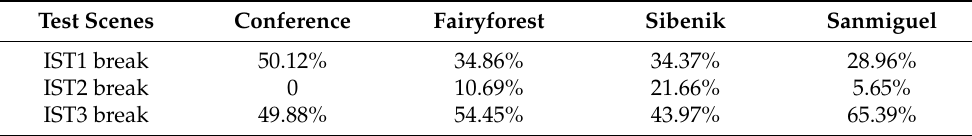
Table 2. Three-phase break for intersection test results.